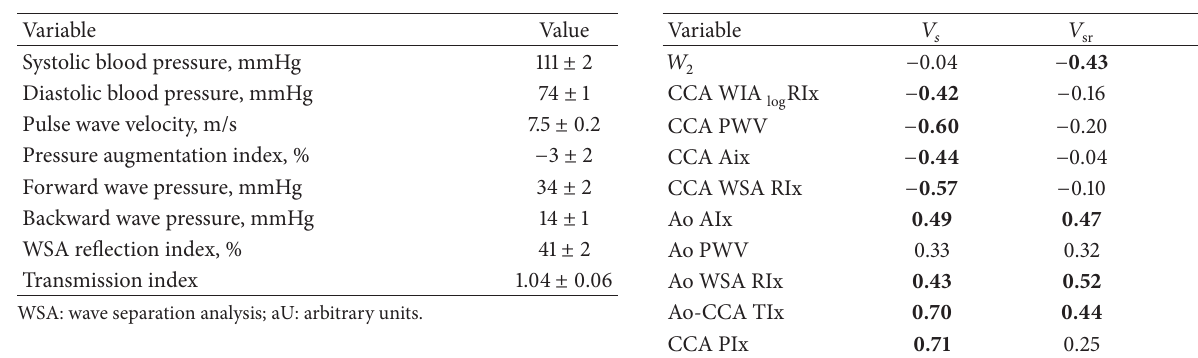
Table 2: Aortic hemodynamic values (mean ± SEM). Table 3: Hemodynamic correlates of the carotid flow